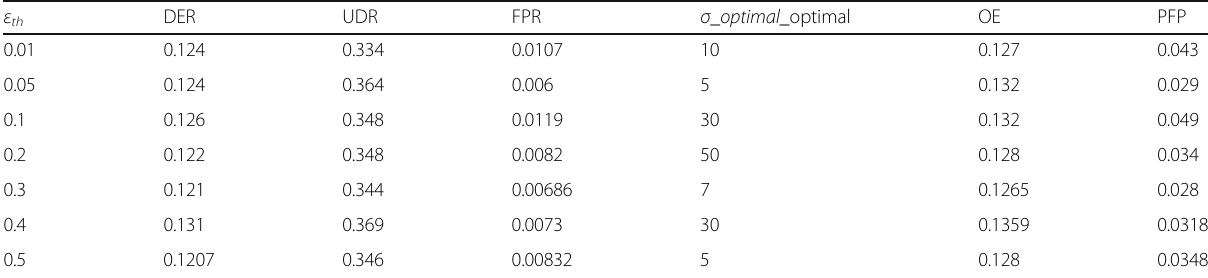
Table 3 Several performance metrics of AdaBoostRBFSVM classifier with different ε th on the optimal σ values ε